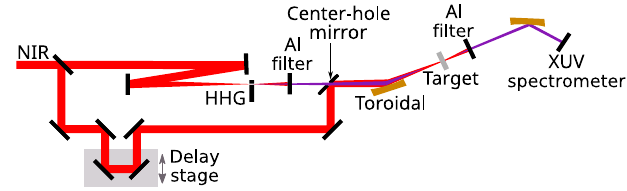
FIG. 4. Sketch of the attosecond transient absorption spectros- copy (ATAS) setup. The pump (NIR) and probe (XUV) beams are recombined with a center-hole mirror and focused on the target by a toroidal mirror. The transmitted XUV spectra are recorded with an XUV spectrometer. Both aluminum filters have a thick- ness of 100